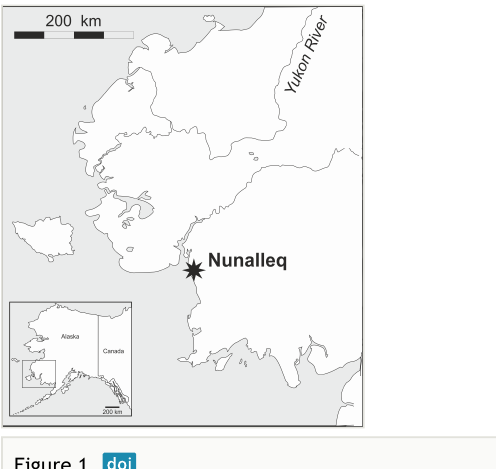
Figure 1. Map of the Yukon-Kuskokwim Delta region of Alaska, showing the location of the Nunalleq archaeological site (image by P.